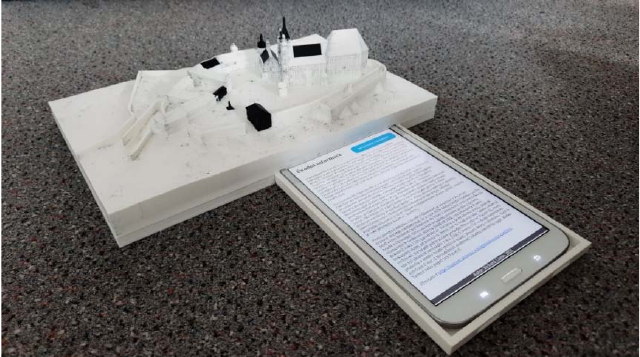
Figure 8. Haptic 3D model of Wenceslas Hill. It is composed of the main segment and modified model base. The tablet device for displaying the content is also shown.